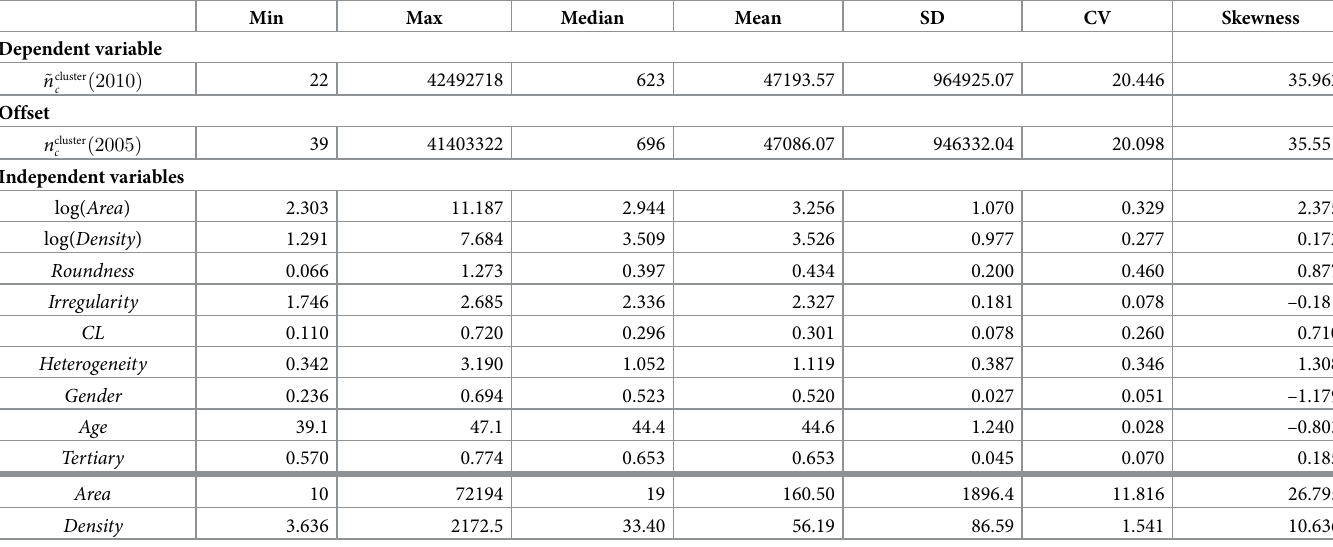
Table 1. Descriptive statistics for the clusters composed of at least ten cells.